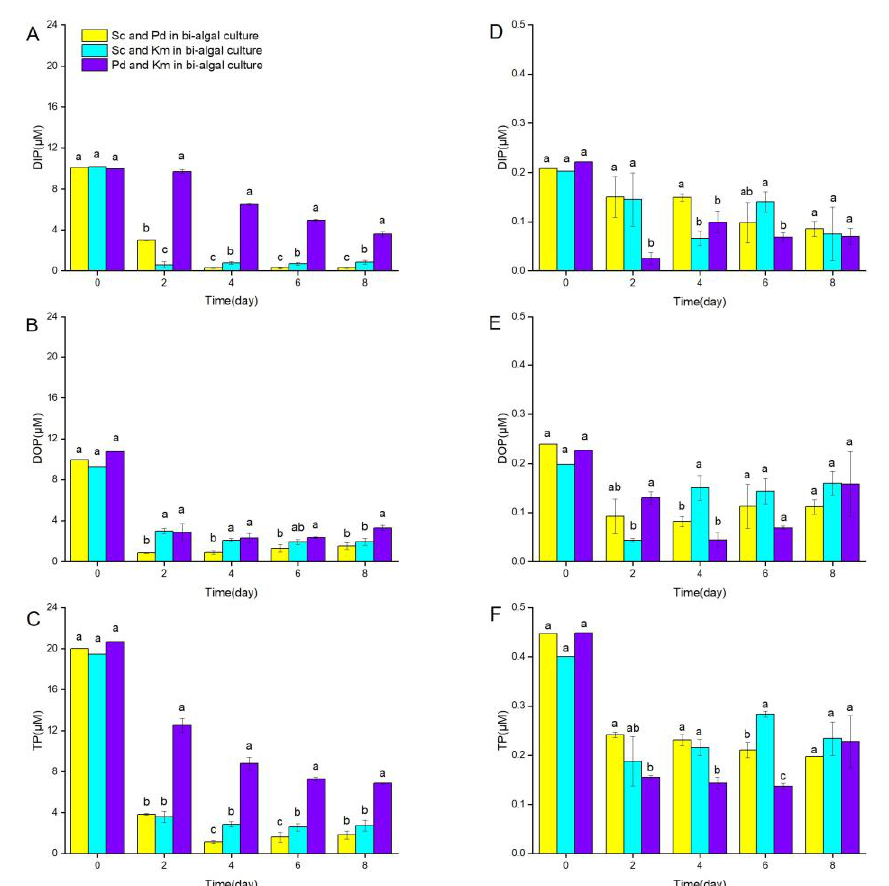
Figure 5. Concentration changes of DIP, DOP, and TP of P. donghaiense , S. costatum, and K. mikimotoi in bi-algal culture under P-sufficient ( A – C )/deficient ( D – F ) conditions, respectively. The values are the mean ± S.D. ( n = 3), with the different lower-case letters indicating significant ( p < 0.05) differences among the different bi-algal cultures.